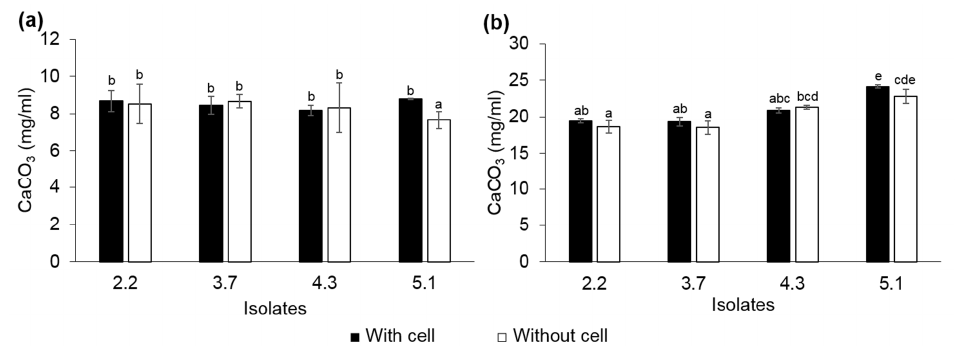
Figure 5. Precipitation of CaCO 3 by the ureolytic bacteria grown in TSB supplemented with 2% urea, incubated for 48 h with addition of 0.1 M ( a ) and 0.4 M ( b ) CaCl 2 . Values are mean ± SD. Different letters indicate significance differences (one ‐ way ANOVA; p < 0.05; Duncan’s multiple range test). The morphology of the CaCO 3 particles produced in the culture broth of L. fusiformis 5.1 and L. xylanilyticus 4.3 was observed under SEM, as shown in Figure 6. Irregular spher ‐ ical particles with sizes ranging between 9.68 and 22.90 μ m were mainly observed. A small number of smaller rod ‐ shaped particles was detected. Bacterial cells were also found on the surface of the CaCO 3 particles. The XRD spectra were used to analyze the mineralogy of the precipitant using a CuK α radiation source ( λ = 1.5406 Å). The XRD patterns which overall ranged from 10° to 80° (2 θ ), confirmed that the CaCO 3 polymorph of the particle from both isolates was calcite (Figure 6e, f).